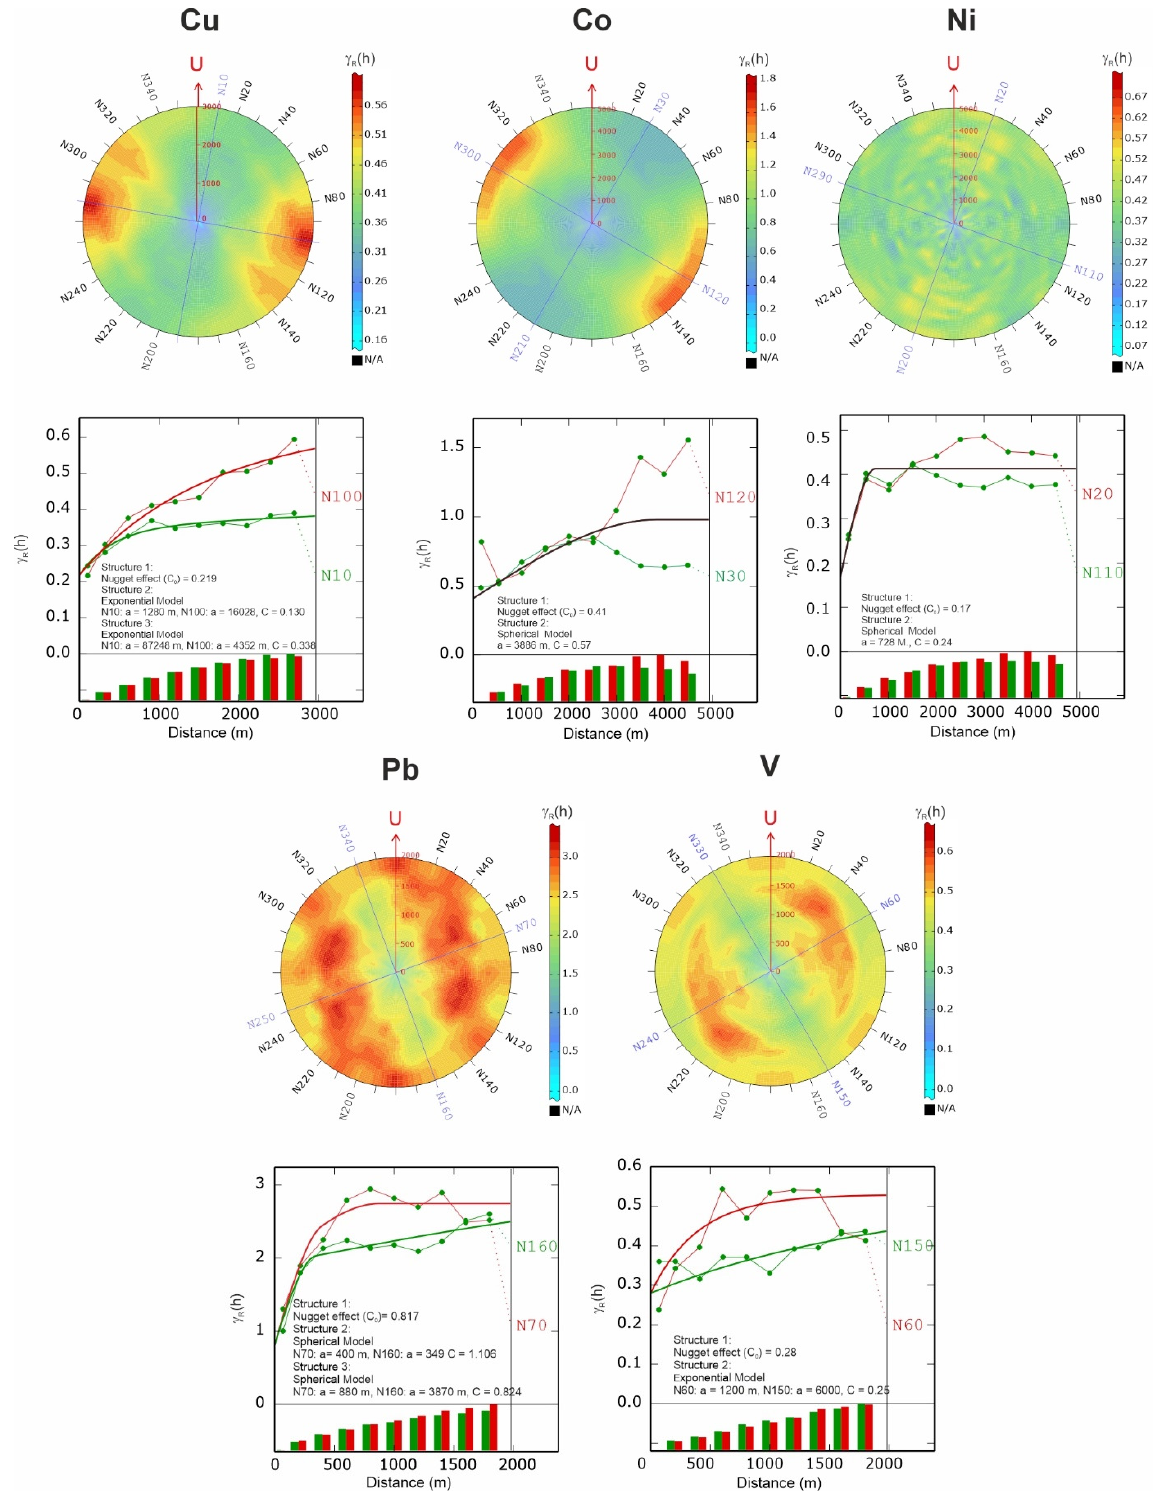
Figure 9. Maps of relative directional variograms of elements abundance and variograms for the directions of minimum (green lines) and maximum (red lines) variability approximated by theoretical models (the anisotropy direction were measured in degrees clock-wise from the North).